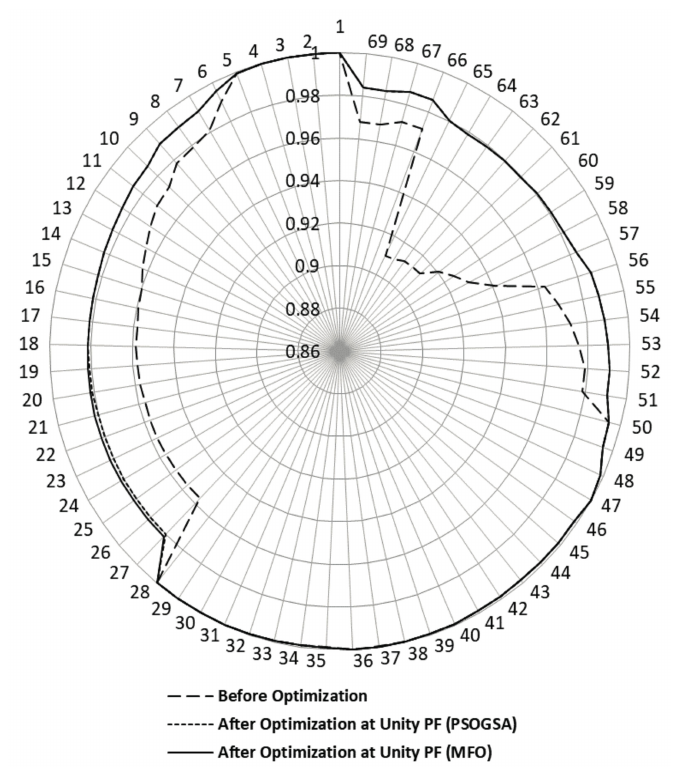
Figure 22. The impact of compensated devices on voltage profile for 69-bus IEEE system at unity PF.